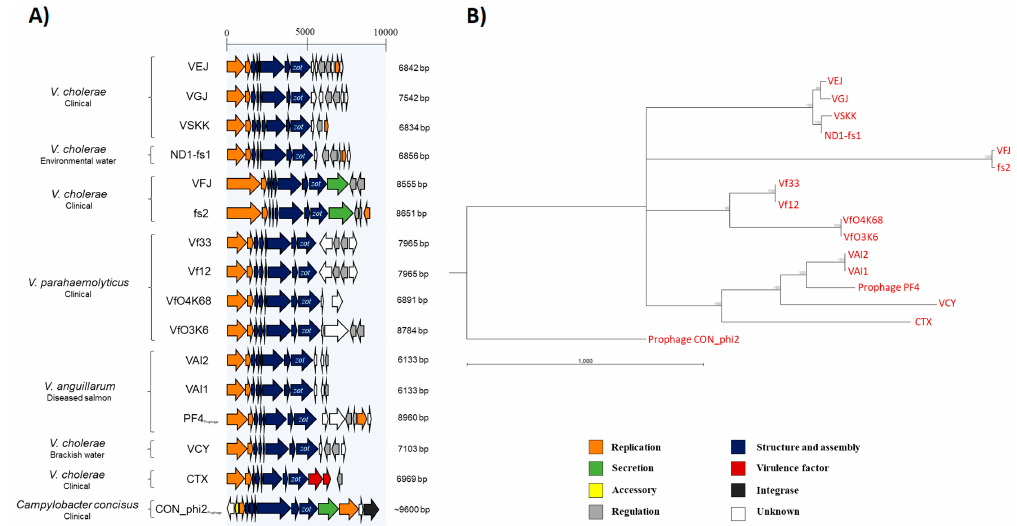
Figure 2. Schematic representation of annotated prophages, inoviruses and their phylogenetic relationship based on conserved genes. ( A ) Inoviruses and prophages in Vibrio hosts and their source of isolation; a Campylobacter concisus prophage as the outgroup was included. Linearized Inovirus- related sequences were aligned for visual comparison and arrows represent the ORFs and their transcription direction. Colors were assigned according to the putative function, which was predicted based on the ORF synteny, size, presence of transmembrane helices, signal peptides and their predicted subcellular localization. ( B ) Phylogenetic relationship of Inoviridae- related vibriophages and a prophage based on concatenated amino acid sequences of 8 conserved ORFs involved in replication, structure and assembly. The concatenated sequence was used to construct the phylogenetic tree using the maximum likelihood algorithm (100 bootstraps). Only bootstrap values supporting branches > 80 are shown. VSK, KSF-1 ϕ and fs1 were excluded of this analysis as mutations caused premature stop codons in some of the generic ORFs.